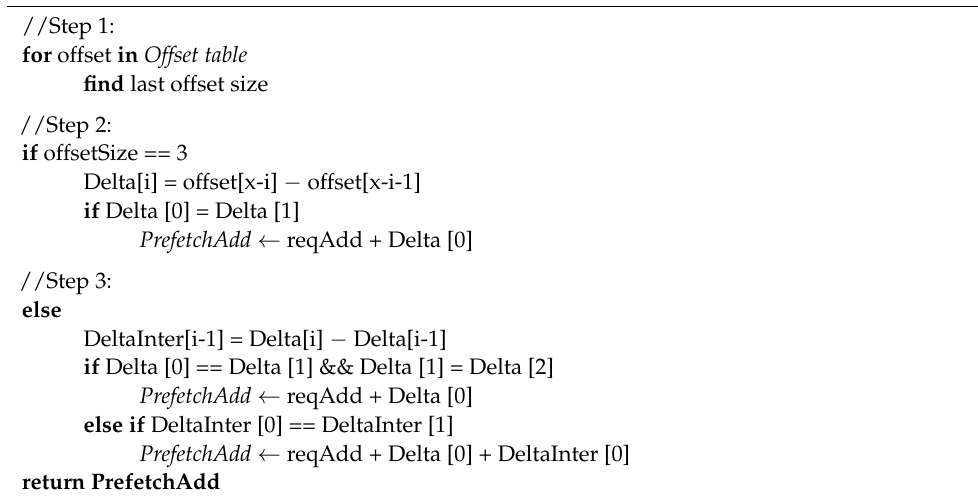
Algorithm 2: Regular stride prefetch